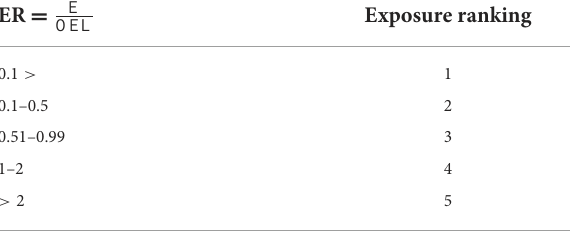
Exposure ranking